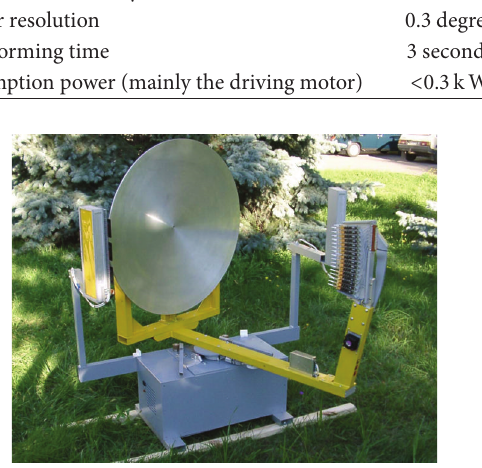
Figure 5: The 8 mm imaging